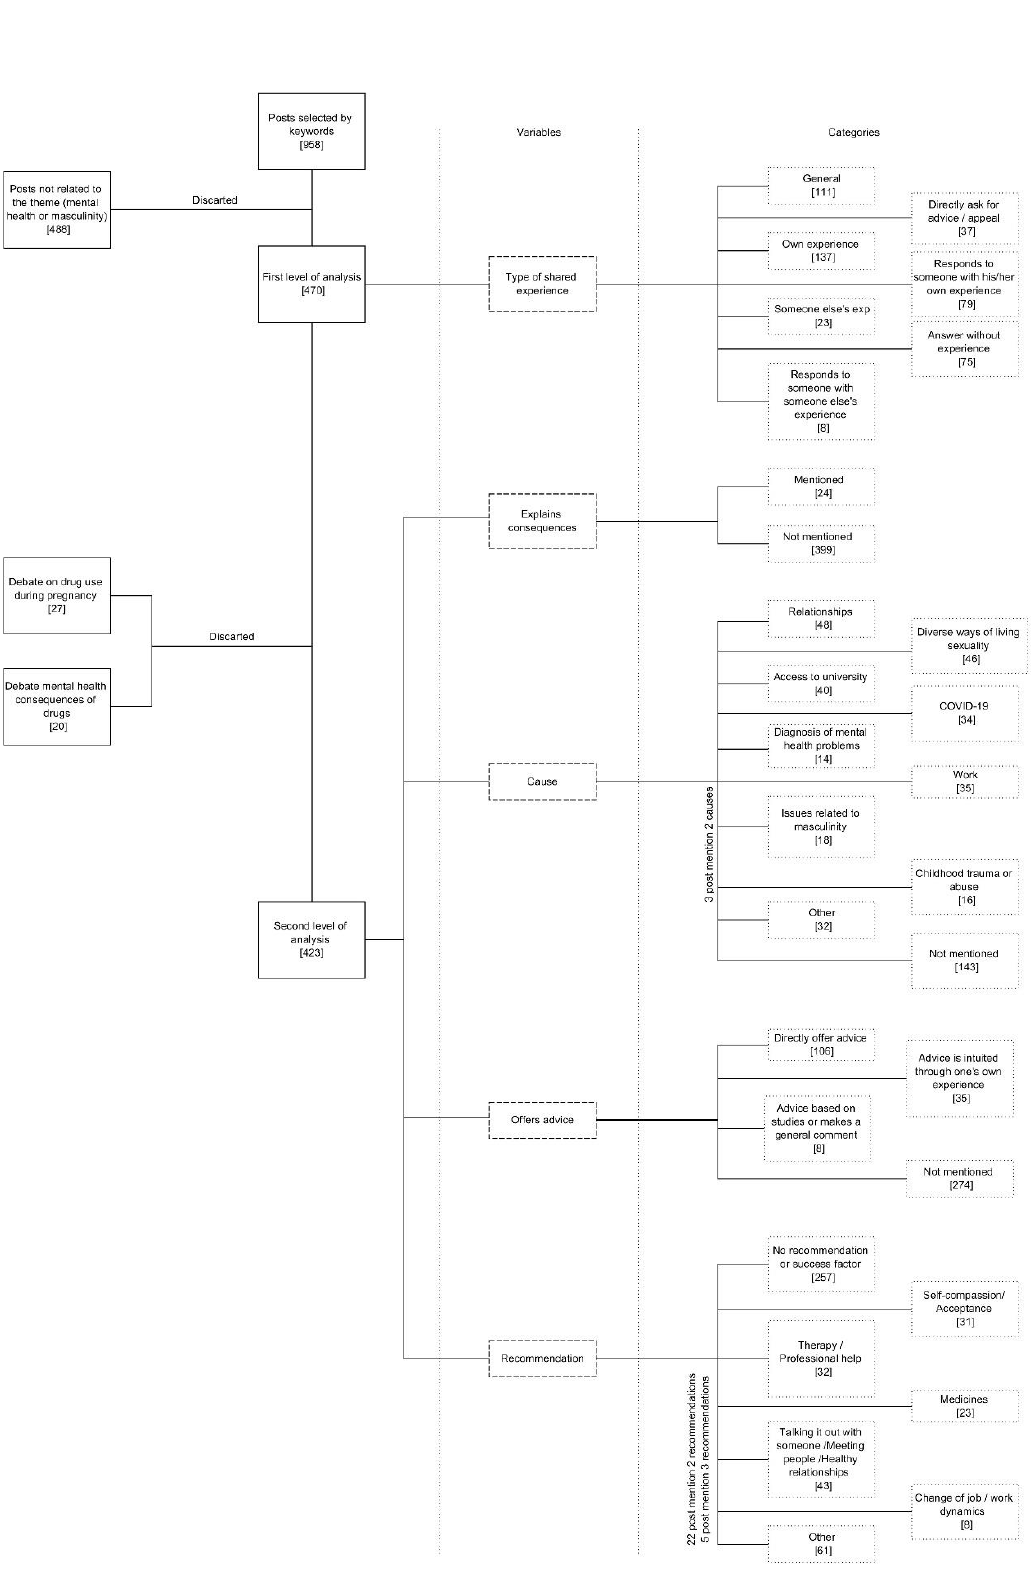
Figure 1. Number of posts by variables and categories.